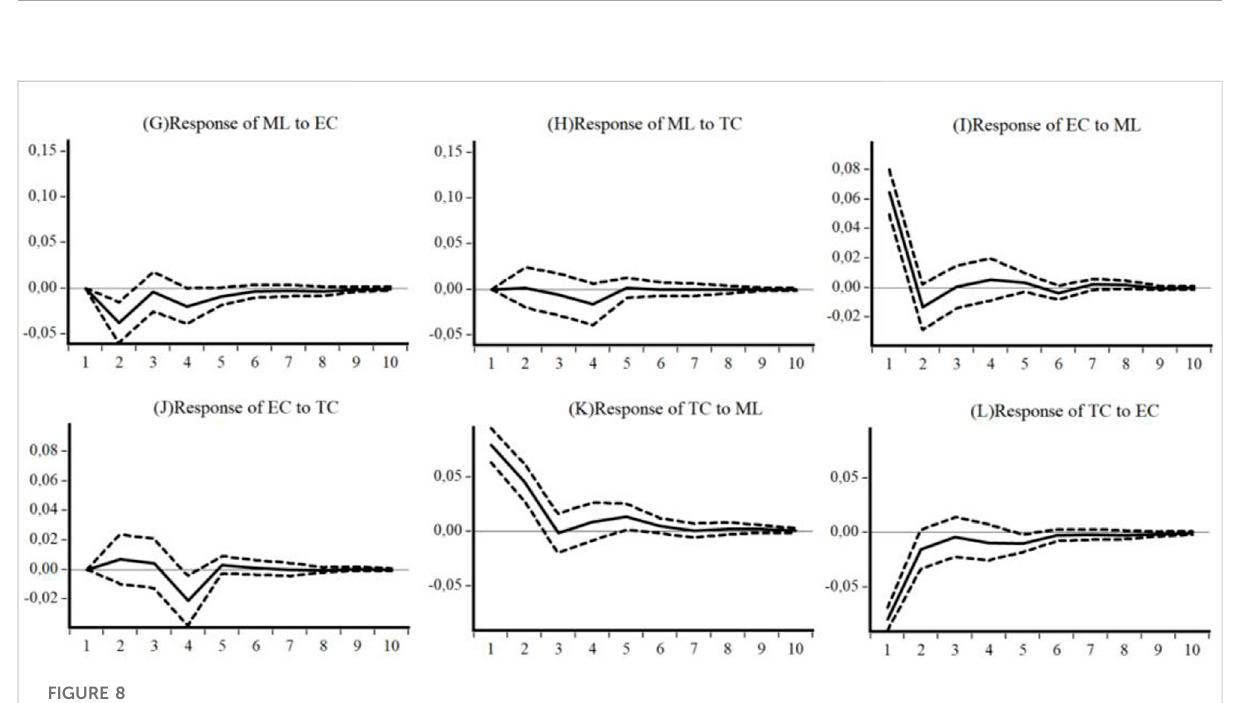
FIGURE 8 Impulse responses of ML , EC , and TC , eastern region. (G) Response of ML to EC, (H) Response of ML to TC, (I) Response of EC to ML, (J) Response of EC to TC, (K) Response of TC to ML, (L) Response of TC to EC.